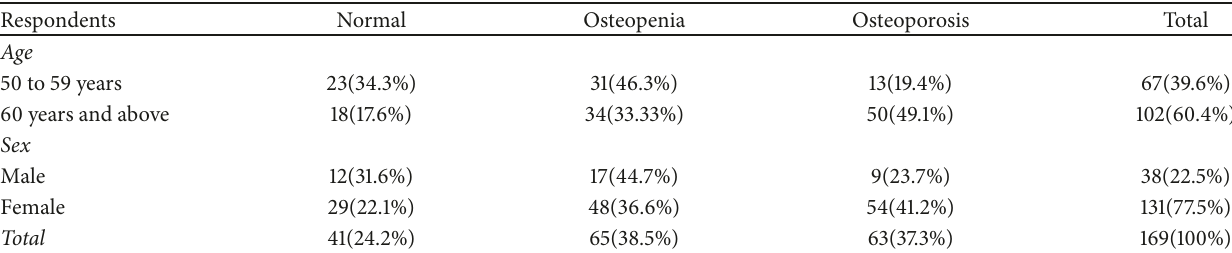
Table 3: Prevalence of osteoporosis (n=169).